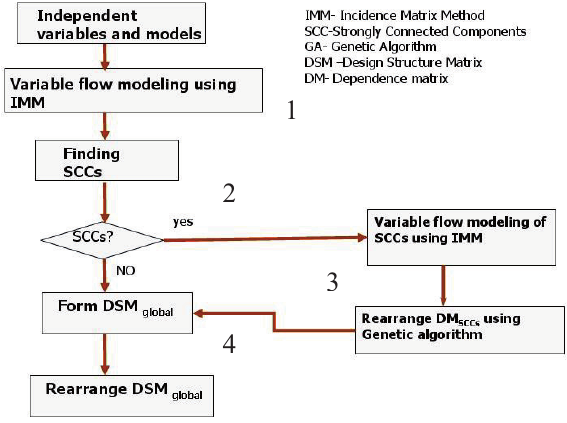
Fig. 1. Flow chart for process